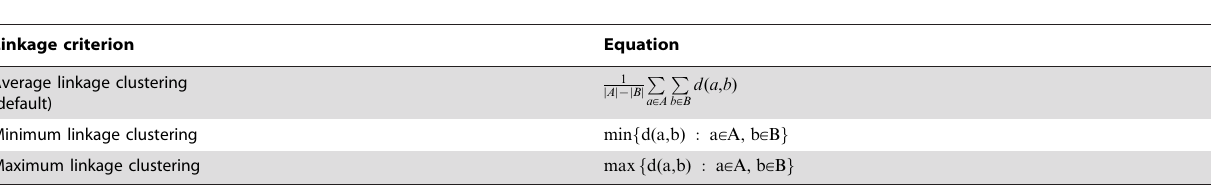
Table 3. Three mostly used linkage criteria for the hierarchical clustering.